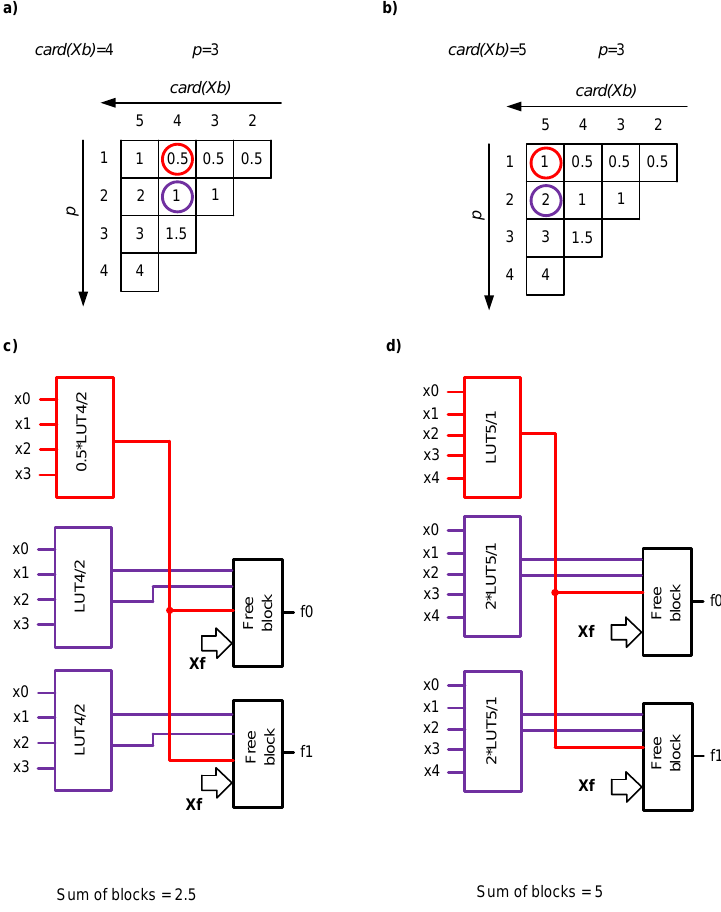
Figure 5. Modified triangle tables ( a ) for card(Xb) = 4, ( b ) for card(Xb) = 5 and obtained mappings ( c ) for card(Xb) = 4, ( d ) for card(Xb) = 5 (sharing blocks is taken into account).